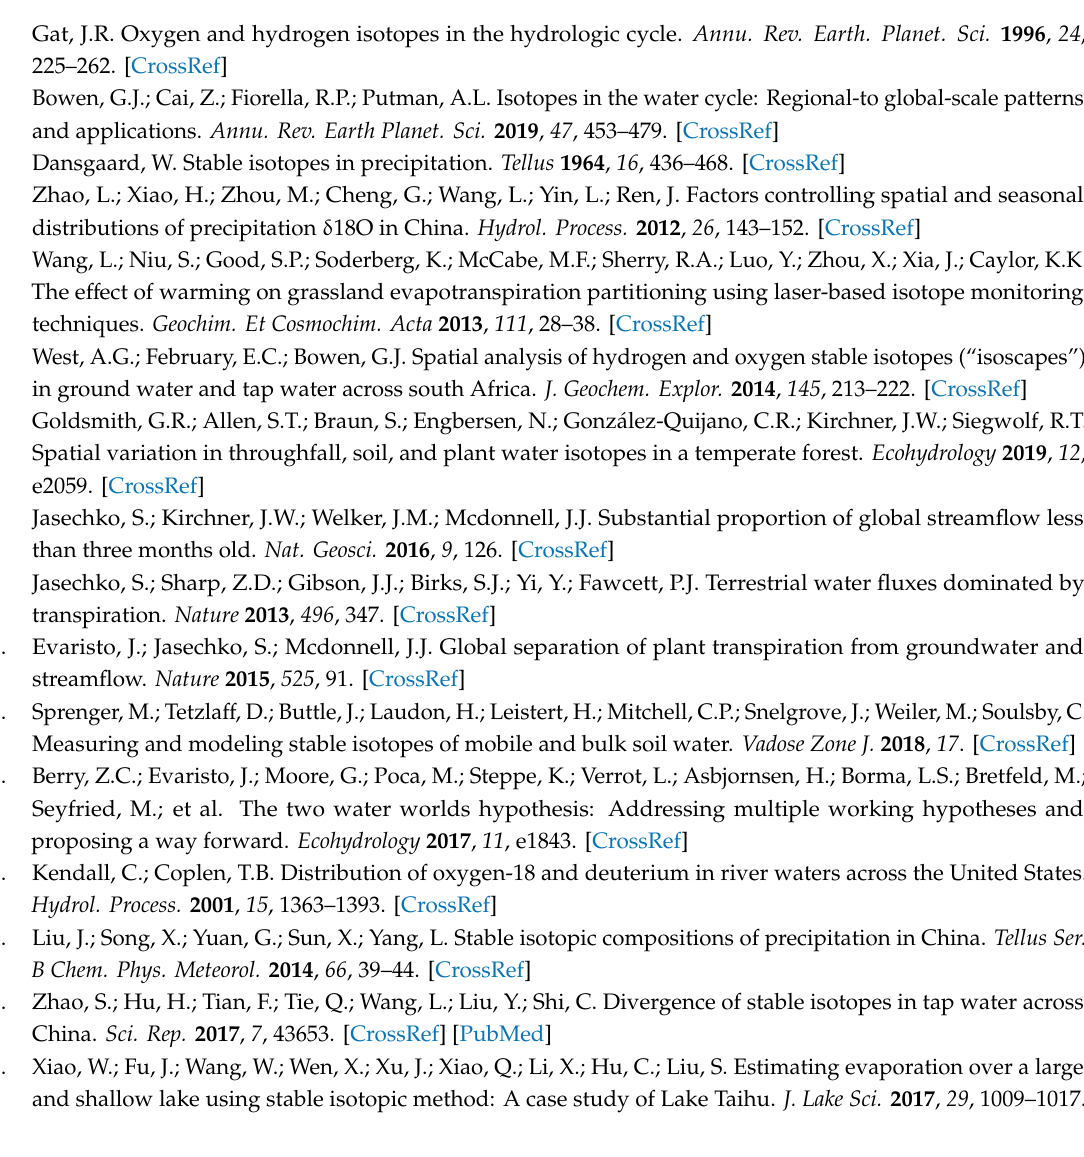
Figure S1: The number of publications on river isotopes that satisfied our criteria from 2001 to 2017, Figure S2: The source journals on which river isotope data were published, Information of data